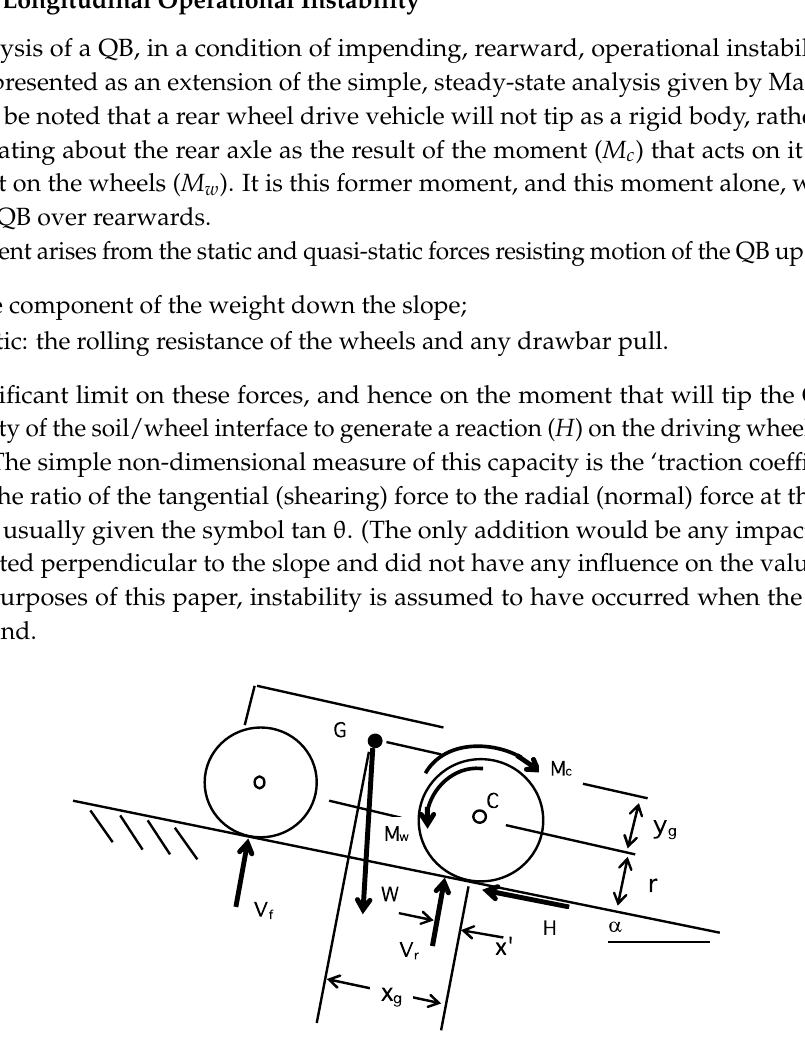
Figure A1. Vehicle being driven at a uniform speed up a slope, angle α .